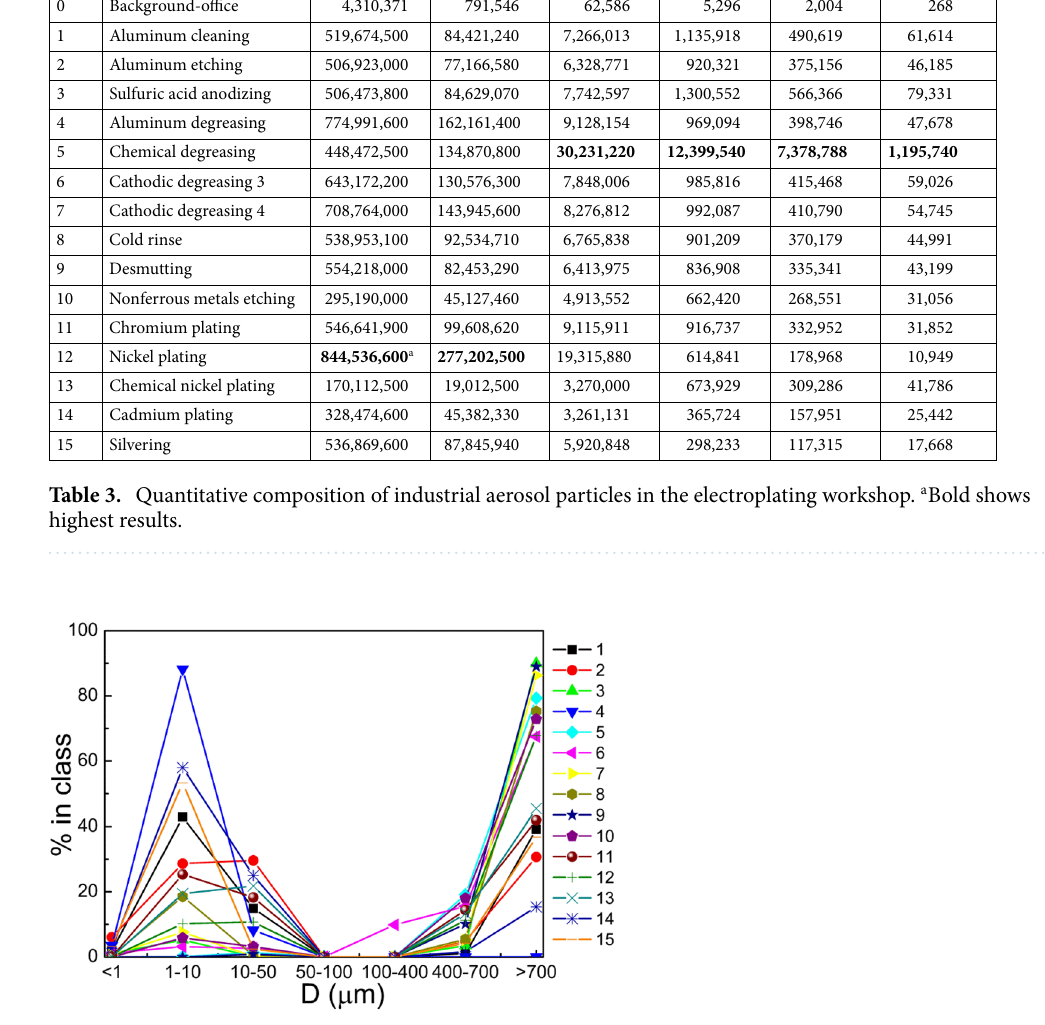
Figure 2. Comparison of size distribution of particles of electroplating origin from all